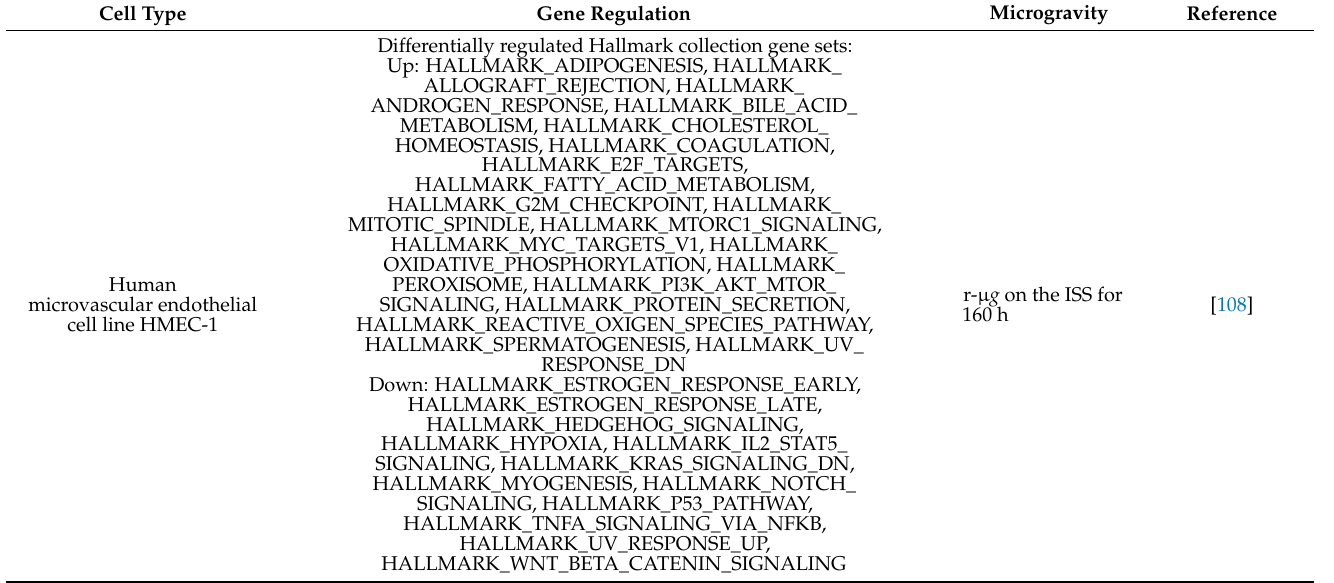
Table 4. Changes in gene regulation of endothelial cells exposed to microgravity